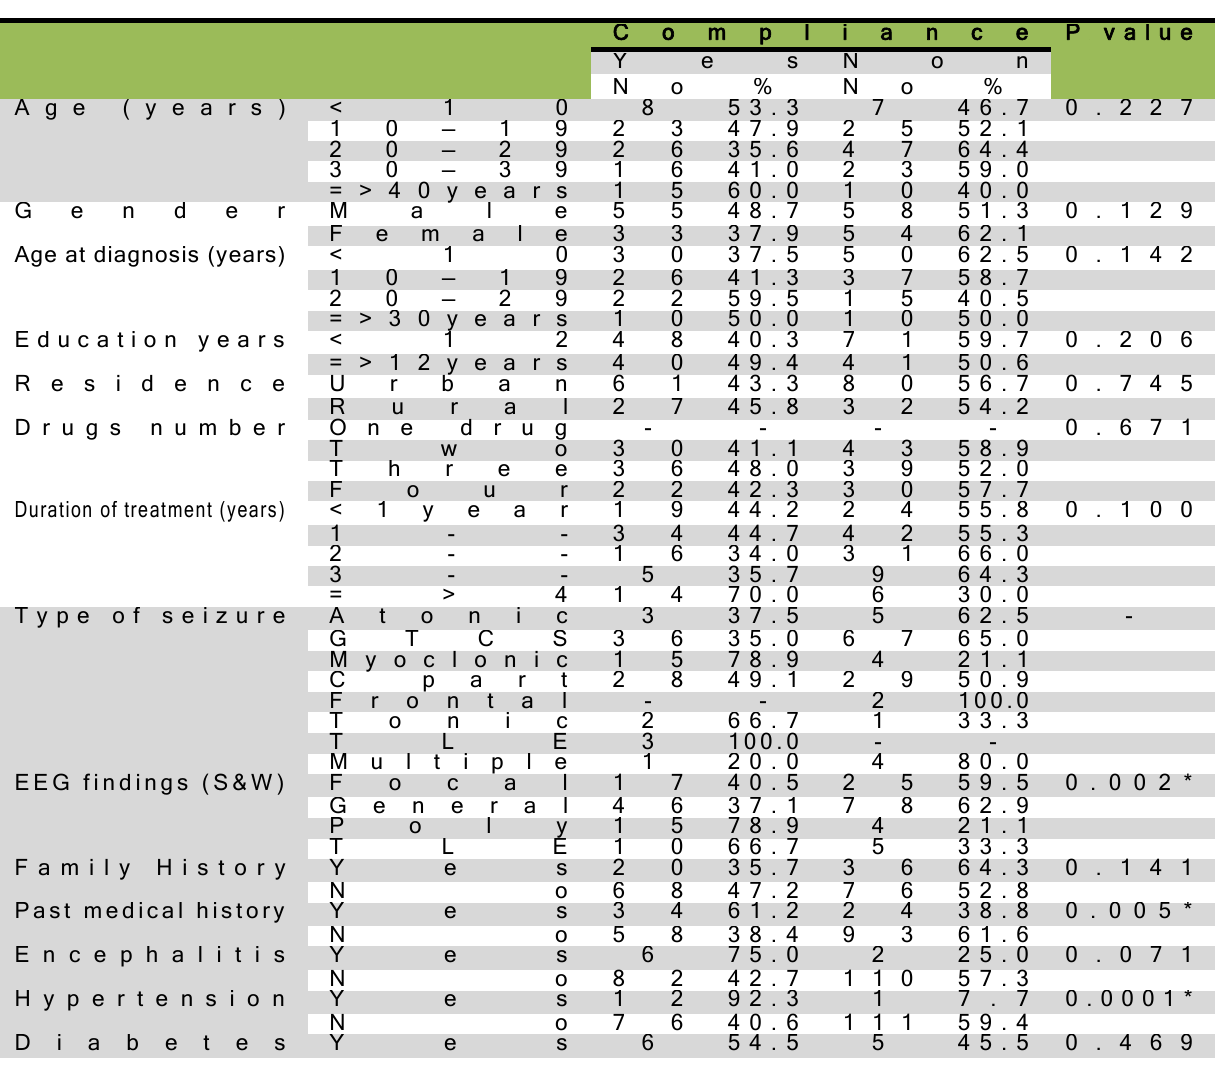
Table 8: Statistical association of compliance and patients'